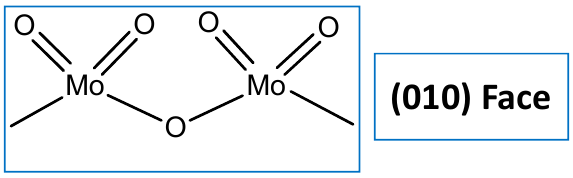
Figure 14. Proposed dual ‐ dioxo catalytic sites on the 010 face of α‐ MoO 3 .